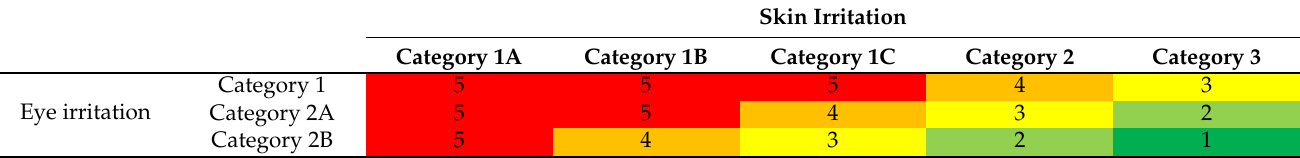
Table 6. Hazard graph for risk